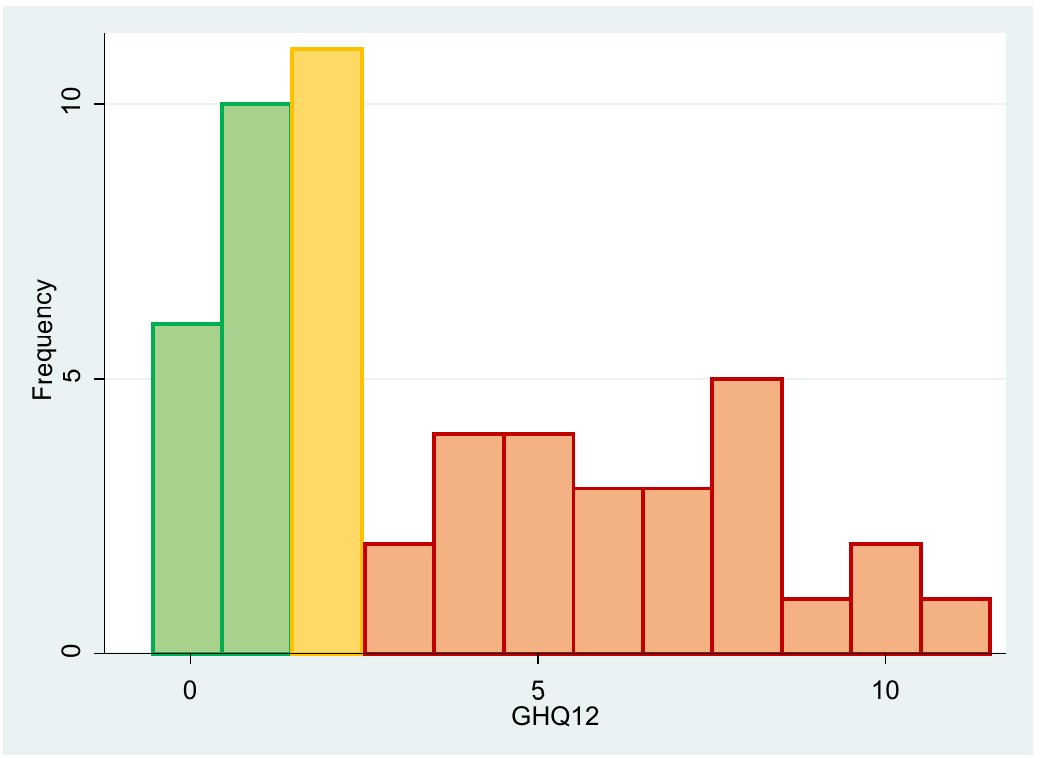
Figure 2. GHQ-12 results’ frequency distribution (with the colours representing the three categories: green = healthy, orange = at risk, red = in psychological distress).